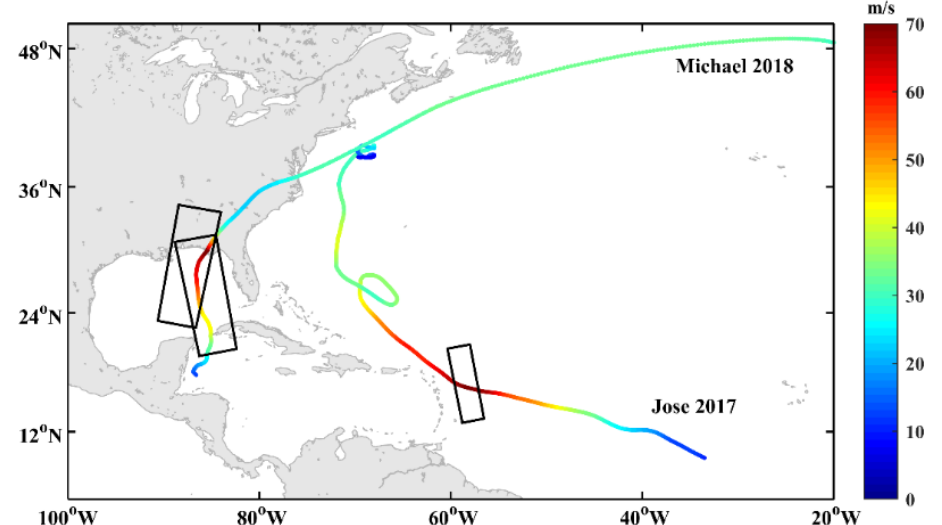
Figure 14. Geolocations of SAR imagery over Hurricane Jose (2017) at 22:03 UTC on 8 September 2017 and Hurricane Michael (2018) at 23:44 UTC on 9 October and 11:50 UTC on 10 October 2018 with respect to the Best Track estimates. The color bar (unit: m/s) denotes hurricane wind speed.